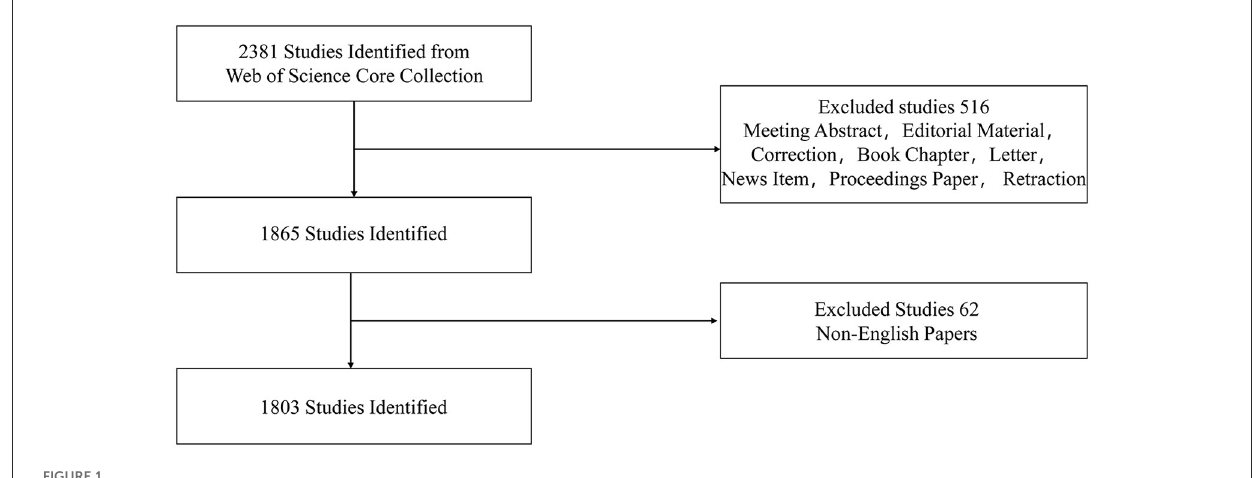
FIGURE1 Flow chat for article